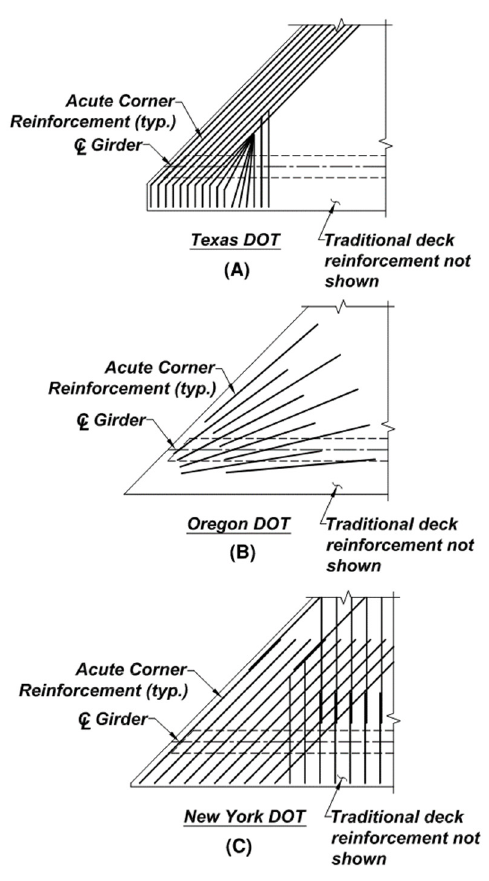
Figure 2. The standard acute corner reinforcement adapted from ( A ) Texas DOT [17], ( B ) Oregon DOT [18], and ( C ) New York State DOT [19].